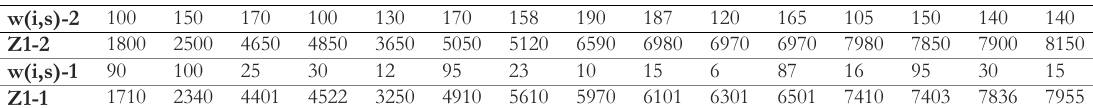
Table 5. The values of the objective function with demand